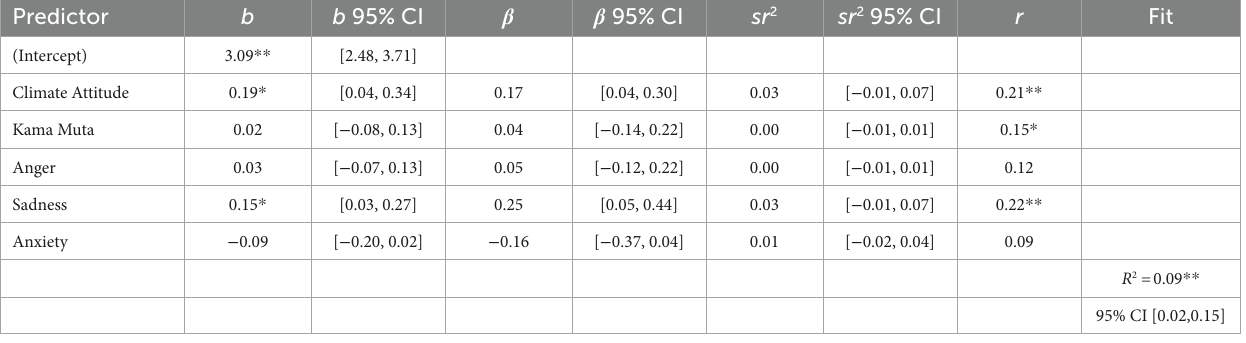
TABLE 4 Regression results using reading time (log) as the criterion in Study 2.